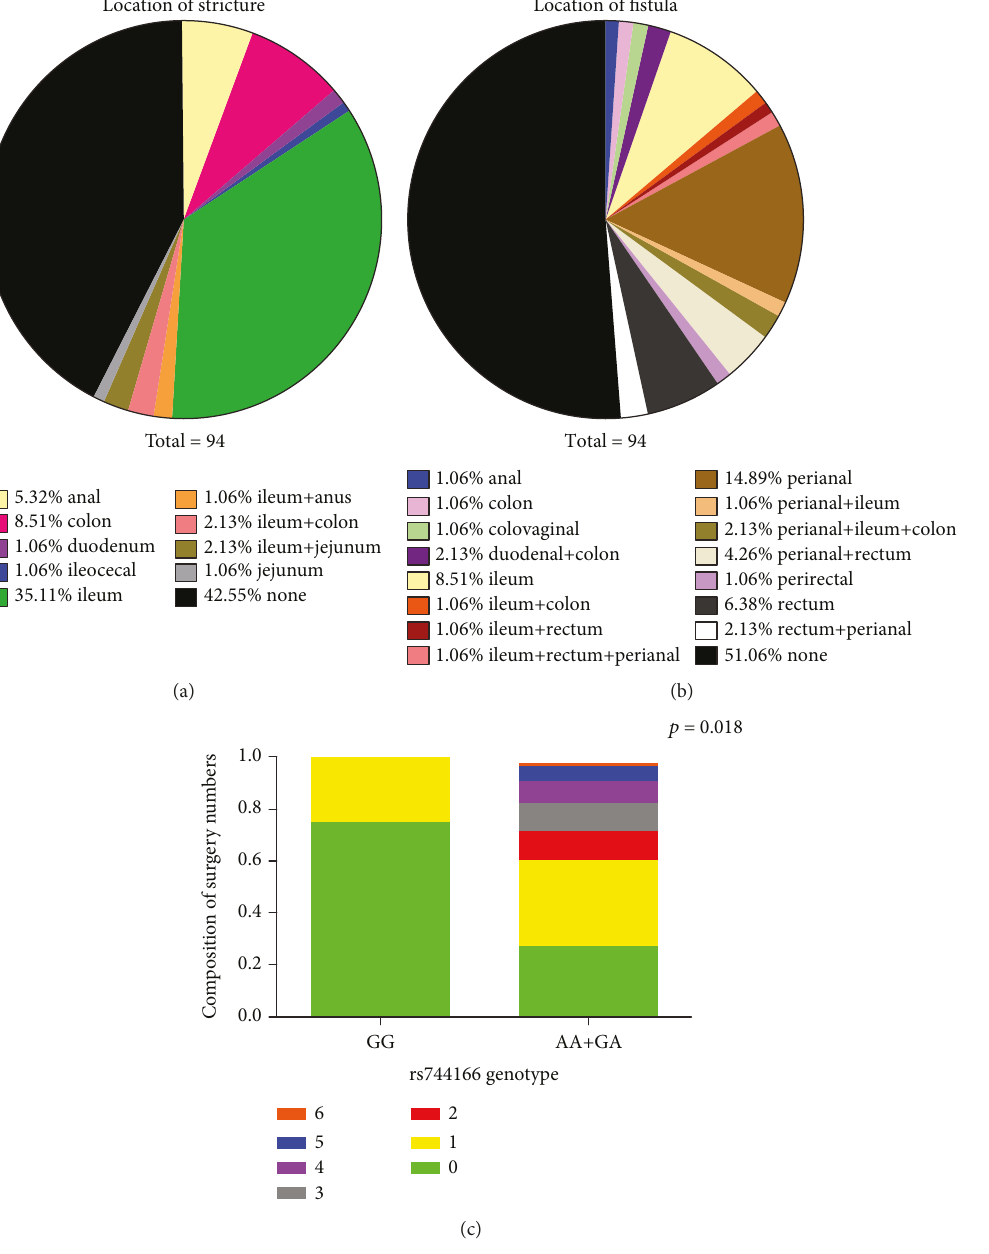
Figure 1: STAT3 rs744166 risky allele “ A ” positively correlateswith surgery numbers in Crohn ’ s disease patients. Patients in this study su ff ered stricture and fi stula at various sites of the gastrointestinal tract. The locations of strictures was shown in (a), and (b) demonstrated various locations of fi stula in this cohort of patients. (c) The correlation of surgery numbers and carriage of risky allele “ A ” was tested by a GENMOD procedure in SAS with the adjustment of age of diagnosis. Di ff erent surgery numbers were represented as di ff erent